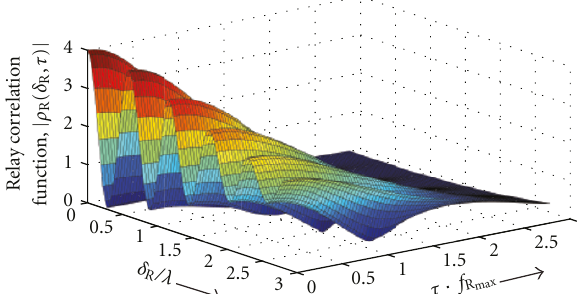
Figure 9: Absolute value of the source CF | ρ S ( δ S , τ ) | of the 2 × 2 × 2 MIMO M2M reference channel model under nonisotropic scattering conditions (von Mises density with φ (0) 40).